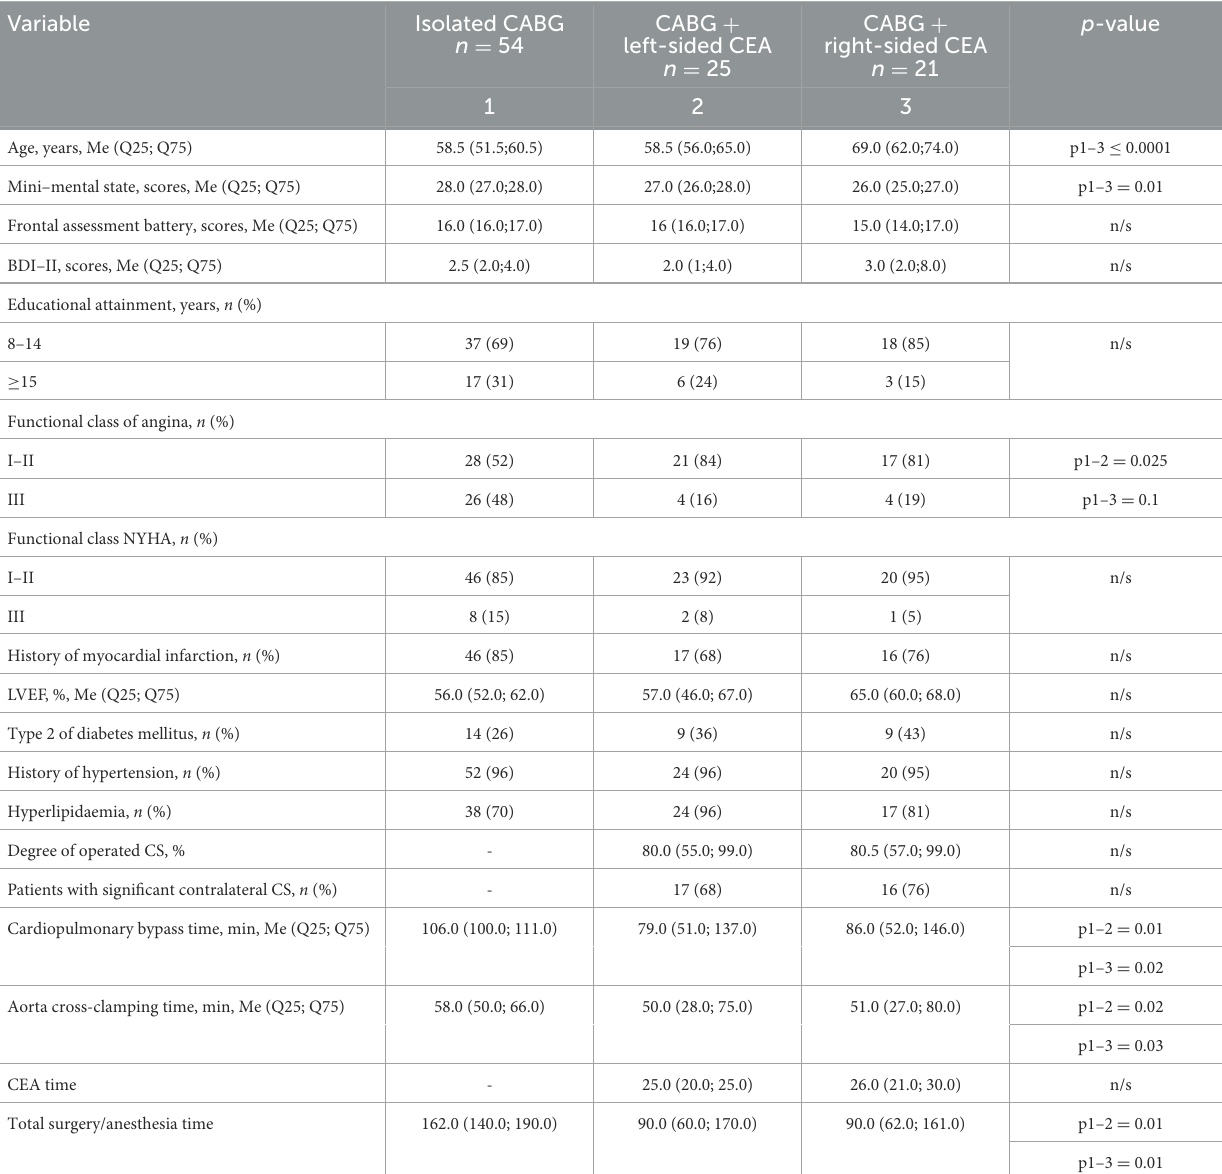
TABLE 1 Clinical and anamnestic characteristics of the groups of the patients before cardiac surgery. Variable Isolated CABG